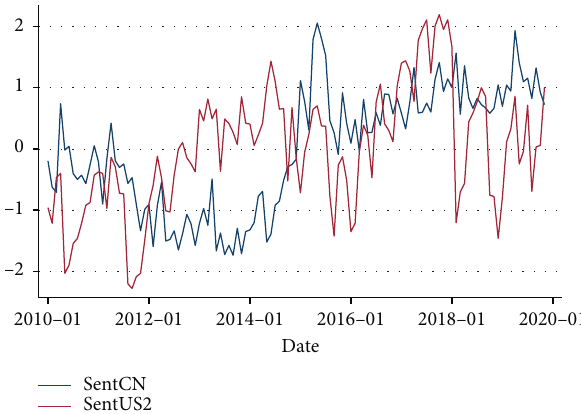
Figure 2: The United States and China investor sentiment